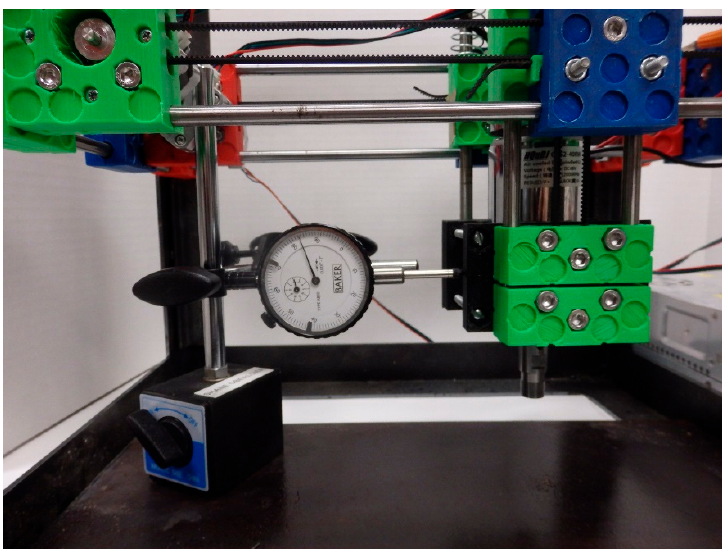
Figure 7. Setup of dial indicator for measuring backlash on X-axis.